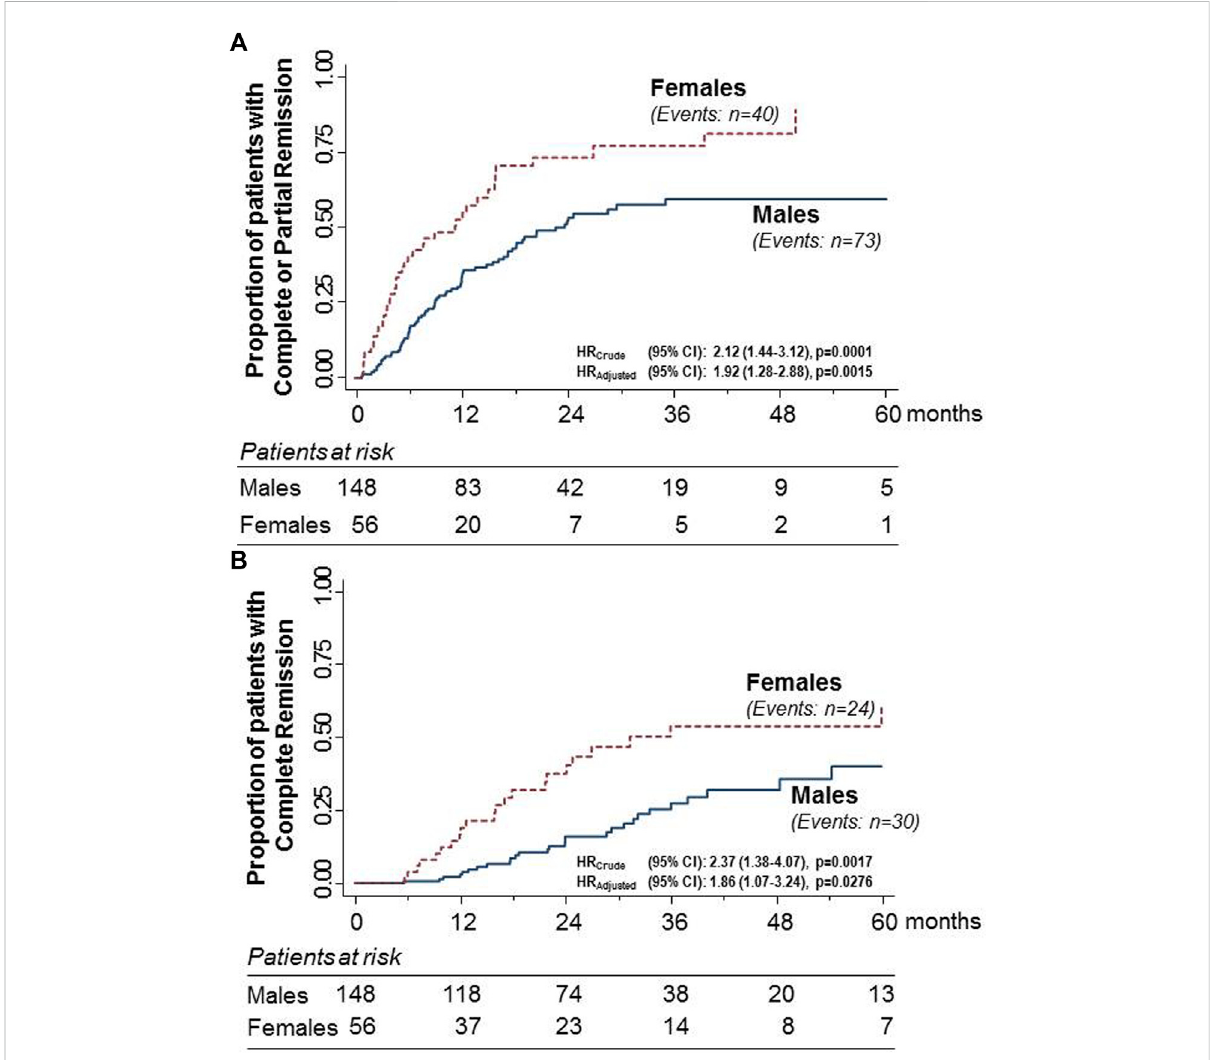
FIGURE 1 Kaplan – Meier curves for the proportion of participants with primary MN who progressed to the combined endpoint of complete or partial remission (A) or to complete remission considered as asingle endpoint (B) in the subgroups of males and females considered separately. The rate of progressiontobothendpointswassigni fi cantlyhigherinfemalesthaninmales.Thedifferencewassigni fi cantevenafteradjustingforbaselineserum creatinine levels.